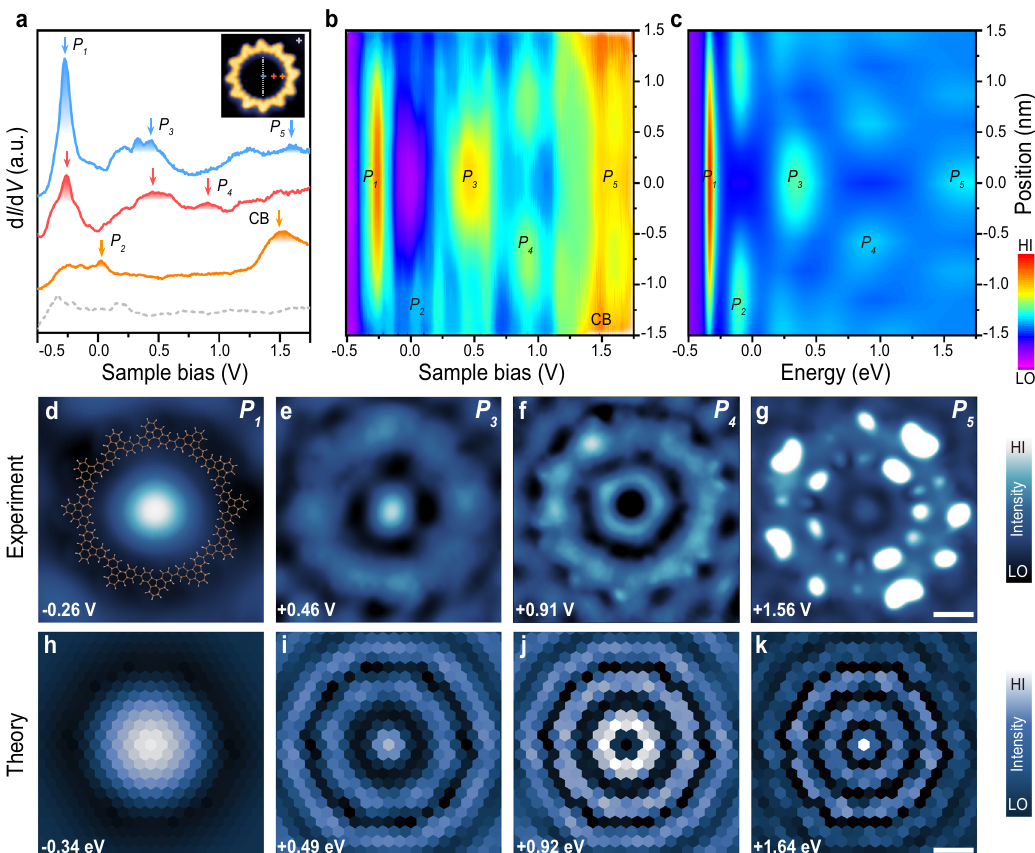
Fig. 3 Characterization of quantum resonance states trapped in a 12-OQC. a Point d I /d V spectra acquired over different sites inside a 12-OQC and Au(111) substrate. d I /d V curves taken at the centre (blue curve), 0.75 nm away from the centre of 12-OQC (red curve), 1.25 nm away from the centre of 12- OQC (orange curve), and taken on Au(111) (grey dashed curve). b Colour-coded d I /d V spectra (spaced by 0.15 nm) taken across the pore of 12-OQC. The actual positions where the d I /d V spectra were taken are indicated by grey dots in the inset STM image in ( a ). c Colour-coded simulated spectral function curves (spaced by 0.15 nm) taken across the pore of potential corral in gold unit cells (Supplementary Fig. 16). d – g Constant-current d I /d V maps recorded at different energy positions ( I = 1 nA for ( d , e ); I = 1.5 nA for ( f , g ). Panels d – g refer to the P 1 ( − 0.26 V), P 3 ( + 0.46 V), P 4 ( + 0.91 V), and P 5 ( + 1.56 V) of resonance states, respectively. (The chemical structure of 12-OQC is superimposed on panel ( d ) to indicate its position.) h – k Simulated spectral function maps acquired at different energy positions close to the energetic positions of these quantum resonance states observed experimentally. Panels h – k refer to the P 1 ( − 0.34 eV), P 3 ( + 0.49 eV), P 4 ( + 0.92 eV), and P 5 ( + 1.64 eV) of resonance states, respectively. Scale bar: 1